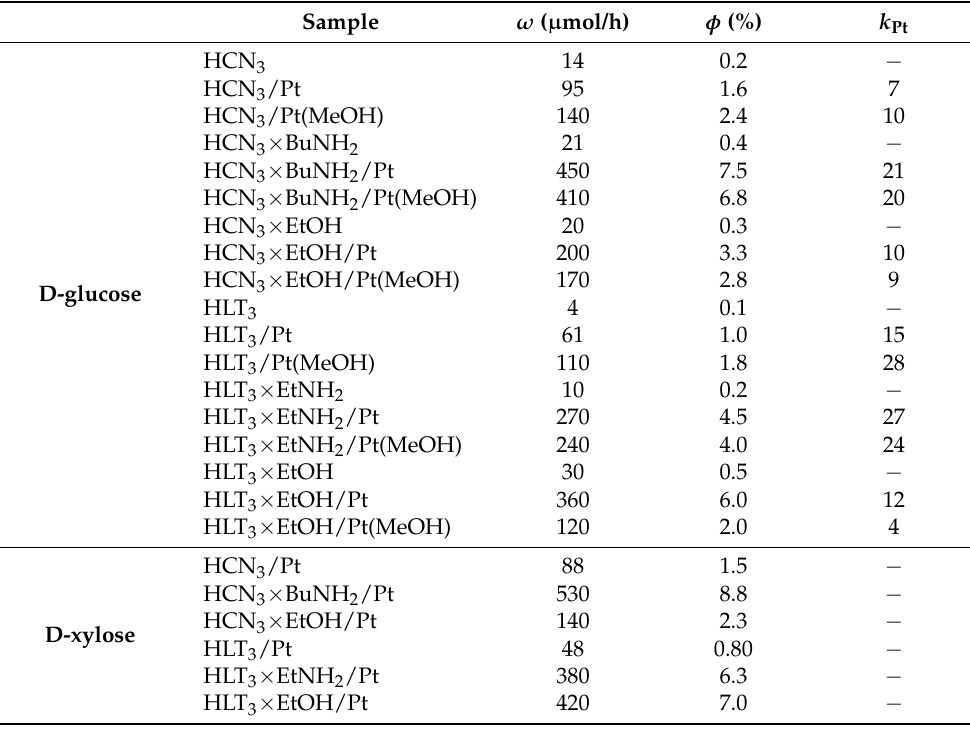
Table 3. Photocatalytic activity of the protonated oxides and inorganic − organic derivatives.